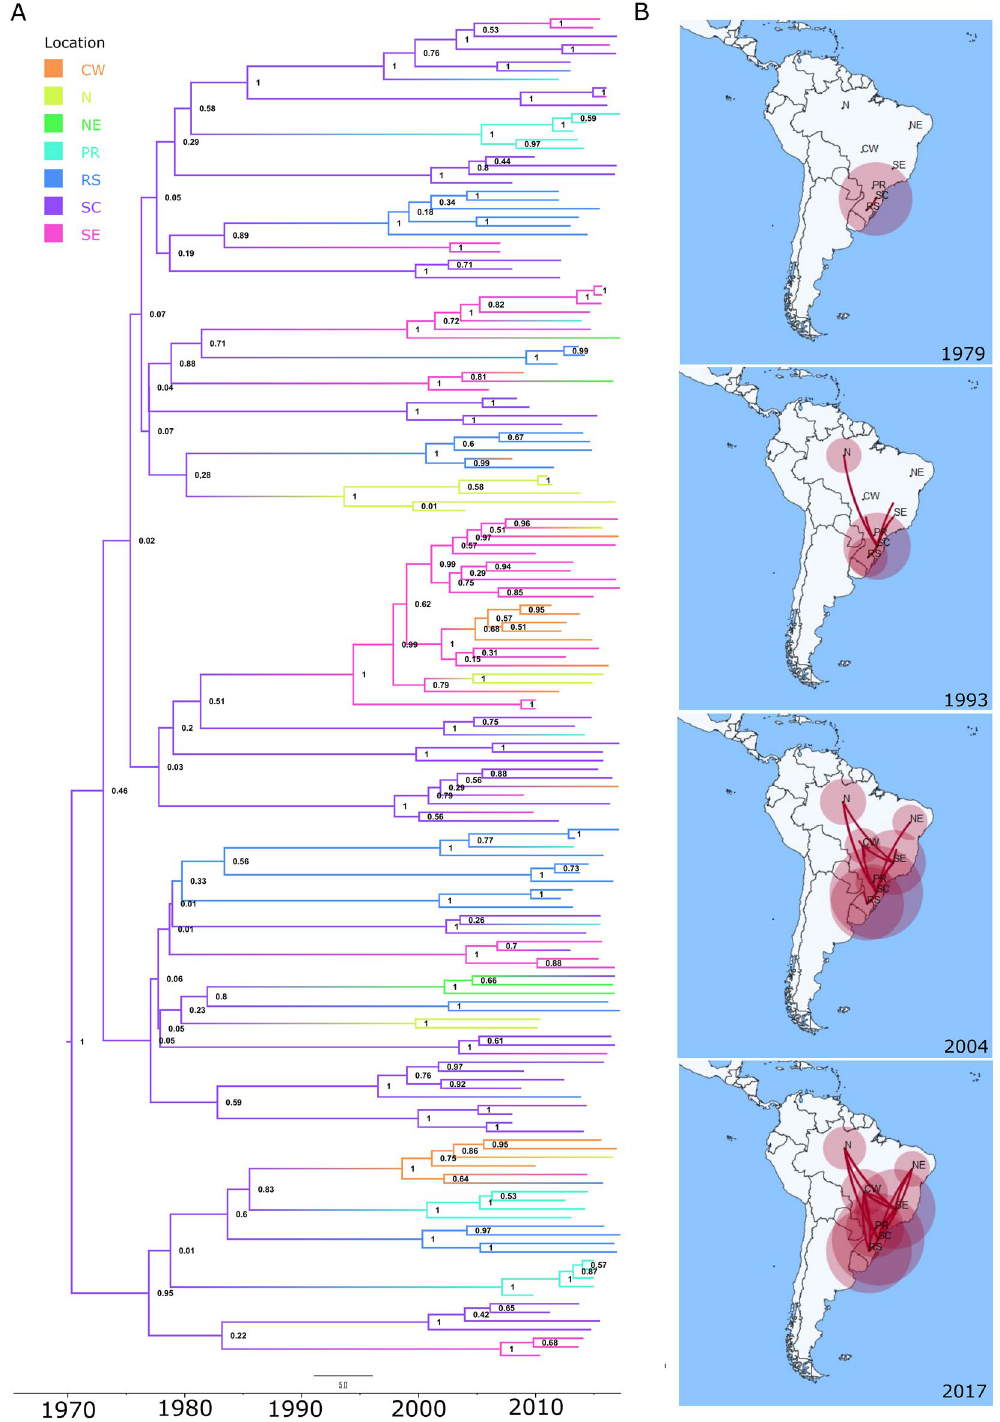
Figure 4. Phylogeographic analysis of the evolution of HIV-1 subtype C transmission clusters. ( A ) Bayesian MCC time scaled discrete phylogeographic tree built using BEAST v1.10.4 of the HIV-1 subtype C sequences included in the transmission clusters that were sampled in Brazil and have complete information (n = 156). Tip location was defined as Brazilian region or state of sample collection. ( B ) Geographical representation of this transmission history. Acronyms and number of sequencies per location: N (North region of Brazil, n = 11), NE (North-East region of Brazil, n = 4), CW (Central-West region of Brazil, n = 14), SE (South-East region of Brazil, n = 34), SC (state of Santa Catarina in the South region of Brazil, n = 43), RS (state of Rio Grande do Sul in the South region of Brazil, n = 31), and PR (state of Paraná in the South region of Brazil, n = 19). SpreaD3 v0.9.6 (https:// rega. kuleu ven. be/ cev/ ecv/ softw are/ Sprea D3) was used to visualize the phylodynamic reconstruction resulting from Bayesian